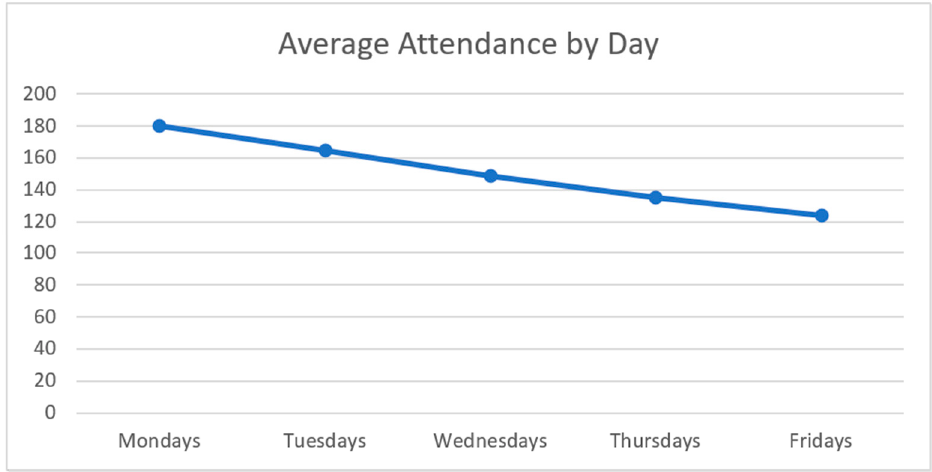
Figure 5. Average RRN huddle attendance by day (May–August